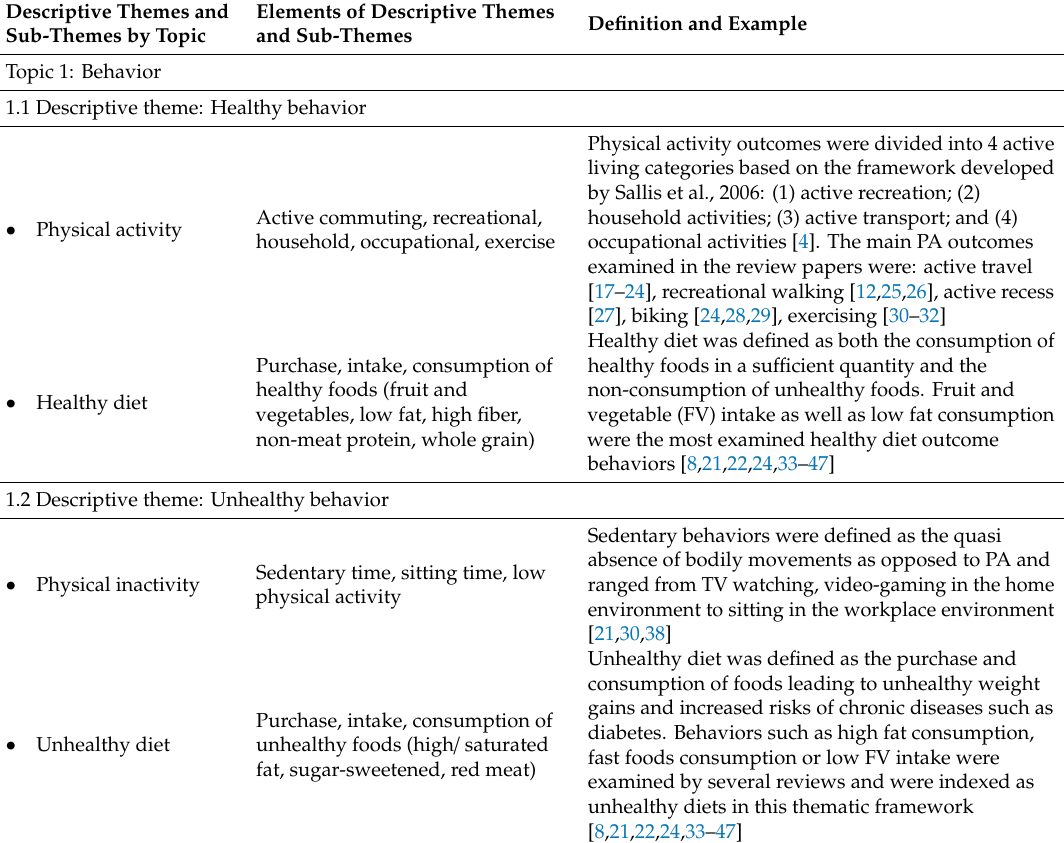
Table 2. Thematic framework used for coding subset